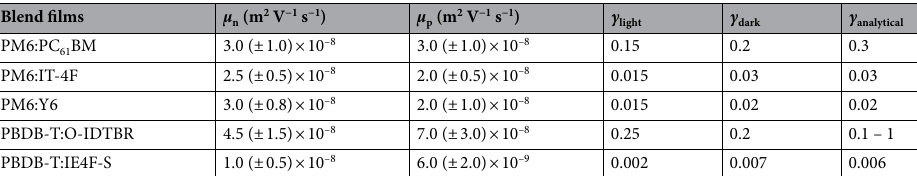
Table 1. Charge-carrier mobility and Langevin prefactors of PM6-based and PBDB-T-based devices. The Langevin prefactors γ light and γ dark are obtained by fitting the J - V characteristics of double-carrier devices under illumination and in dark, respectively, based on the experimental mobilities as obtained from single-carrier devices. The Langevin prefactor γ analytical is obtained via Eq.